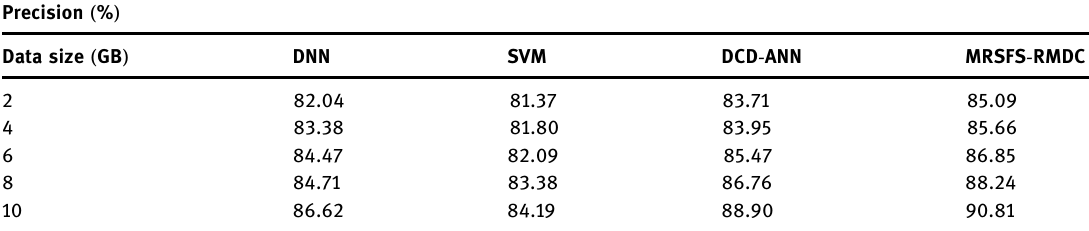
Table 2: Precision analysis of MRSFS - RMDC model with varying data size Precision ( %